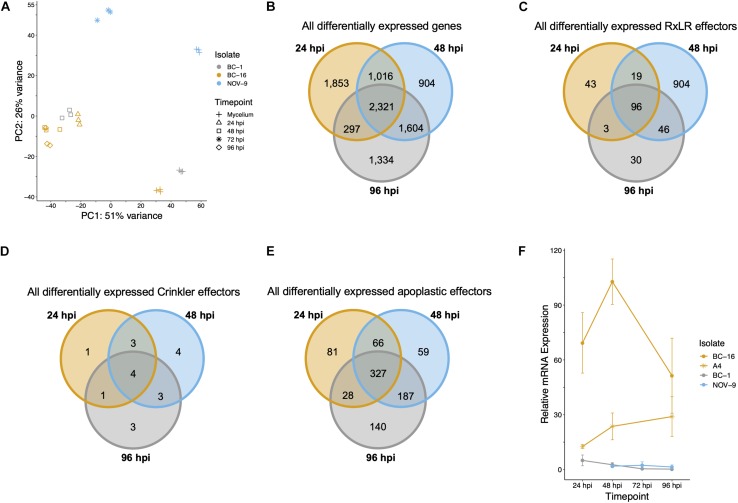
Analysis of expression data showed grouping of biological replicates, a separation of the BC-16 timepoints, changes during the infection process by the BC-16 isolate and confirmation of the differential expression of a candidate avirulence gene. (A) Principal component analysis of the differentially expressed transcripts for all analysed RNA-Seq experiments. RNA-Seq reads were aligned to the assembly of the BC-16 isolate of Phytophthora fragariae using STAR version 2.5.3a (Dobin et al., 2013). Predicted transcripts were then quantified with featureCounts version 1.5.2 (Liao et al., 2014) and differential expression was identified with the DESeq2 version 1.10.1 R package (Love et al., 2014). Following this, an rlog transformation of the expression data was plotted as a principal component analysis with R Core Team (2016). (B) Venn diagram of all differentially expressed transcripts during the BC-16 infection timecourse experiment. (C) Venn diagram of all differentially expressed predicted RxLR effectors during the BC-16 infection timecourse experiment. (D) Venn diagram of all differentially expressed predicted Crinkler effectors during the BC-16 infection timecourse experiment. (E) Venn diagram of all differentially expressed predicted apoplastic effectors during the BC-16 infection timecourse experiment. Venn diagrams were plotted using the VennDiagram R package (Chen and Boutros, 2011) in R Core Team (2016). (F) Quantitative reverse transcription PCR of a strong candidate for the avirulence gene possessed by BC-16 and A4, but not BC-1 and NOV-9 (PF003_g27513.t1). Plots created by the ggplot2 R package (Wickham, 2016) in R version 3.4.3 (R Core Team, 2017).